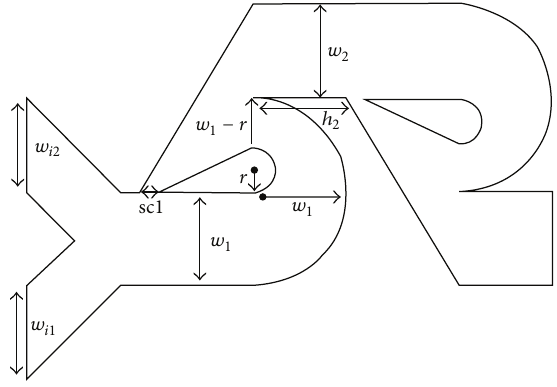
Figure 2: Parameterization of the micromixer